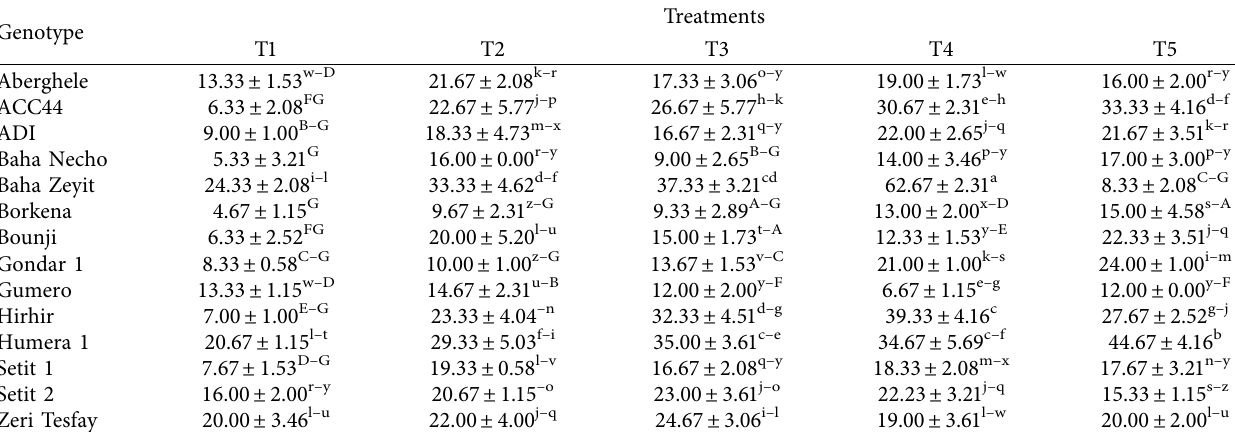
Table 3: Interaction effects of PGRs supplements and genotypes on the mean leaf number.